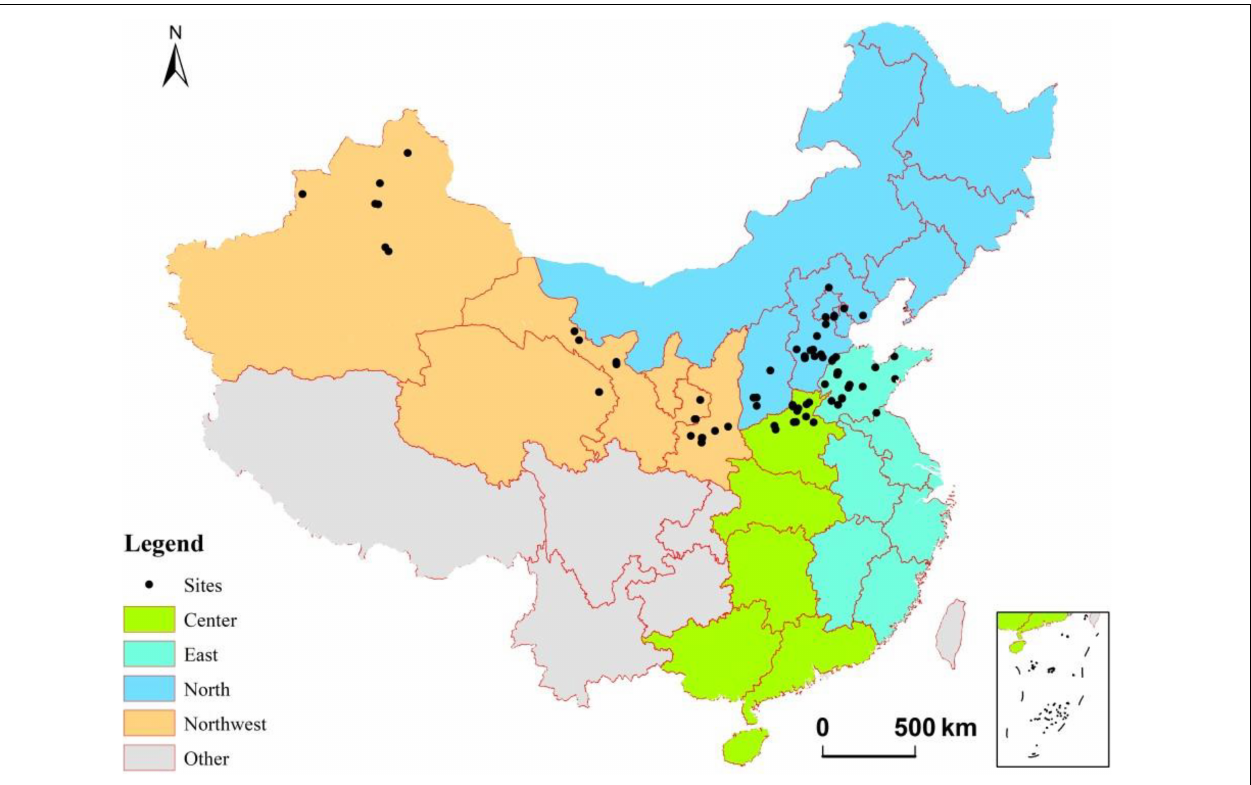
FIGURE 1 | The geographical coverage of the studies used in the meta-analysis. Sites indicate studies’ location included in the current study. Refer to the details of regions classification in section “Literature Selection and Data Extraction”.